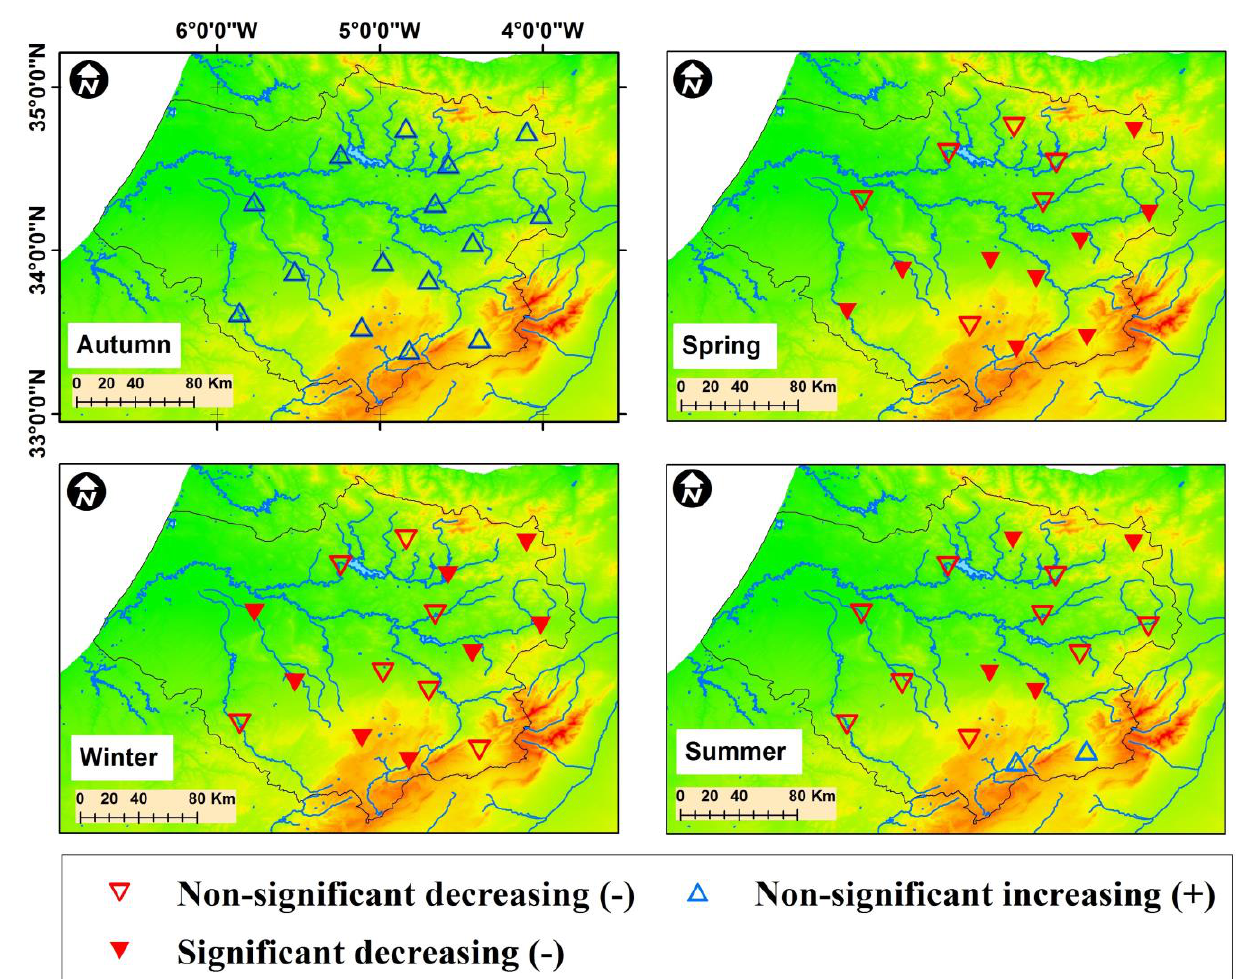
Figure 6. Results of the MK trends test for seasonal rainfall at 15 stations in the SRB. Table 3. Results of Mann–Kendall test for monthly rainfall; bold figures are significant at 95%